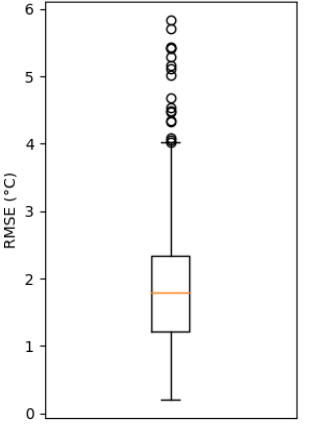
Figure 5. RST ( top ), T2M ( middle ), and RH ( bottom ) between 1 February 2021 and 1 December 2021 at the RWS of Stabroek (black) and from the Bpost cars (red) for nearby road segments (distance to the RWS of maximum 500 m). The scores include the RMSE, bias, and correlation, which are computed from the times series binned on an hourly basis. RST values below − 30 ◦ C are considered unrealistic and not used in the computation of the scores.